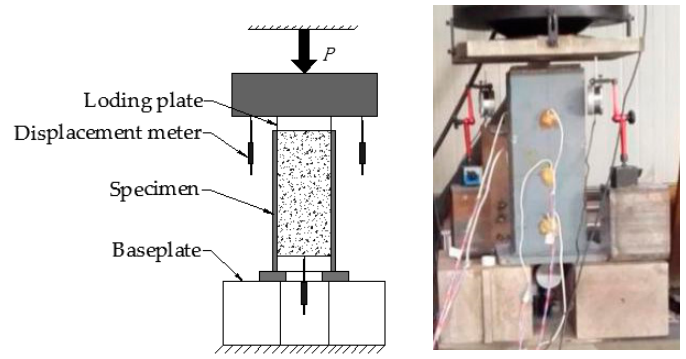
Figure 5. Schematic diagram of test set-up.